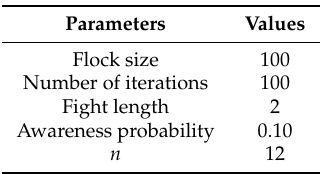
Table 5. Crow Search Algorithm (CSA)